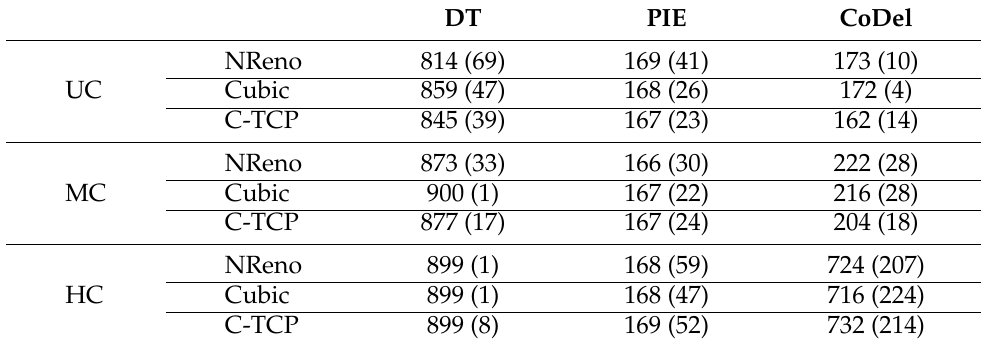
Table 4. Mean queue length and standard deviation of queue length [pkts] in the Data center scenario with common TCPs, UC—uncongested, MC—mildly congested, HC—heavily congested network.